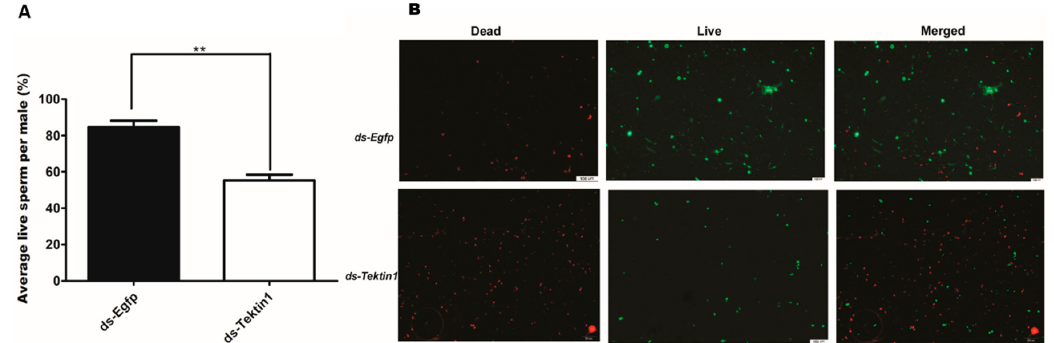
Figure 8. Reduced number of live sperms in the Tektin1 knockdown males ( A ) Percentage of live sperm significantly decreased in flies fed with dsTektin , compared to the control (ds-egfp) group. ( B ) Represents the percentage of live spermatozoa per male. Red indicates dead sperms; green indicates live sperms. One-way ANOVA, along with student t-test, was used to analyze the results. ** indicates p < 0.01.